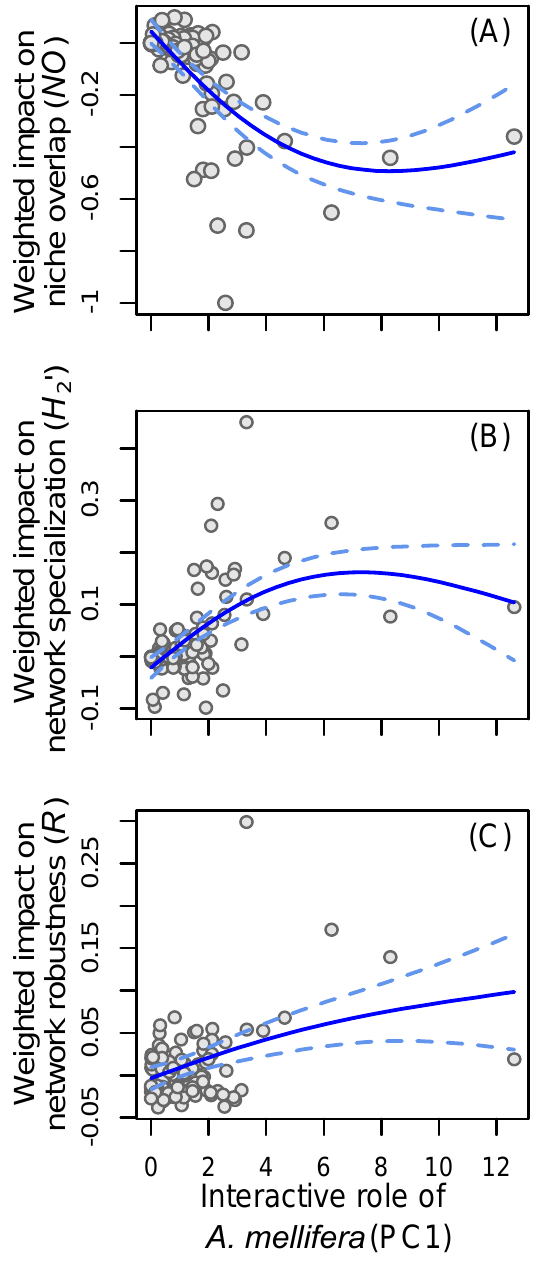
Figure 2. Standardized impacts of the interactive role (PC1) of the honeybee Apis mellifera after its exclusion from the pollination networks by using random species removal simulations on ( A ) plants’ niche overlap (GAMM: F = 49.06; p < 0.001; R 2 ( adj ) = 0.441), ( B ) specialization (GAMM: F = 31.68; p < 0.001; R 2 ( adj ) = 0.341), and ( C ) robustness to species extinction (GAMM: F = 12.52; p < 0.001; R 2 ( adj ) = 0.156). Negative impacts indicate that pollination networks without A. mellifera had lower values of the metrics, while positive impacts indicate that pollination networks without A. mellifera had higher values of the metrics (see text for details). The dotted lines represent 95% confidence limits.